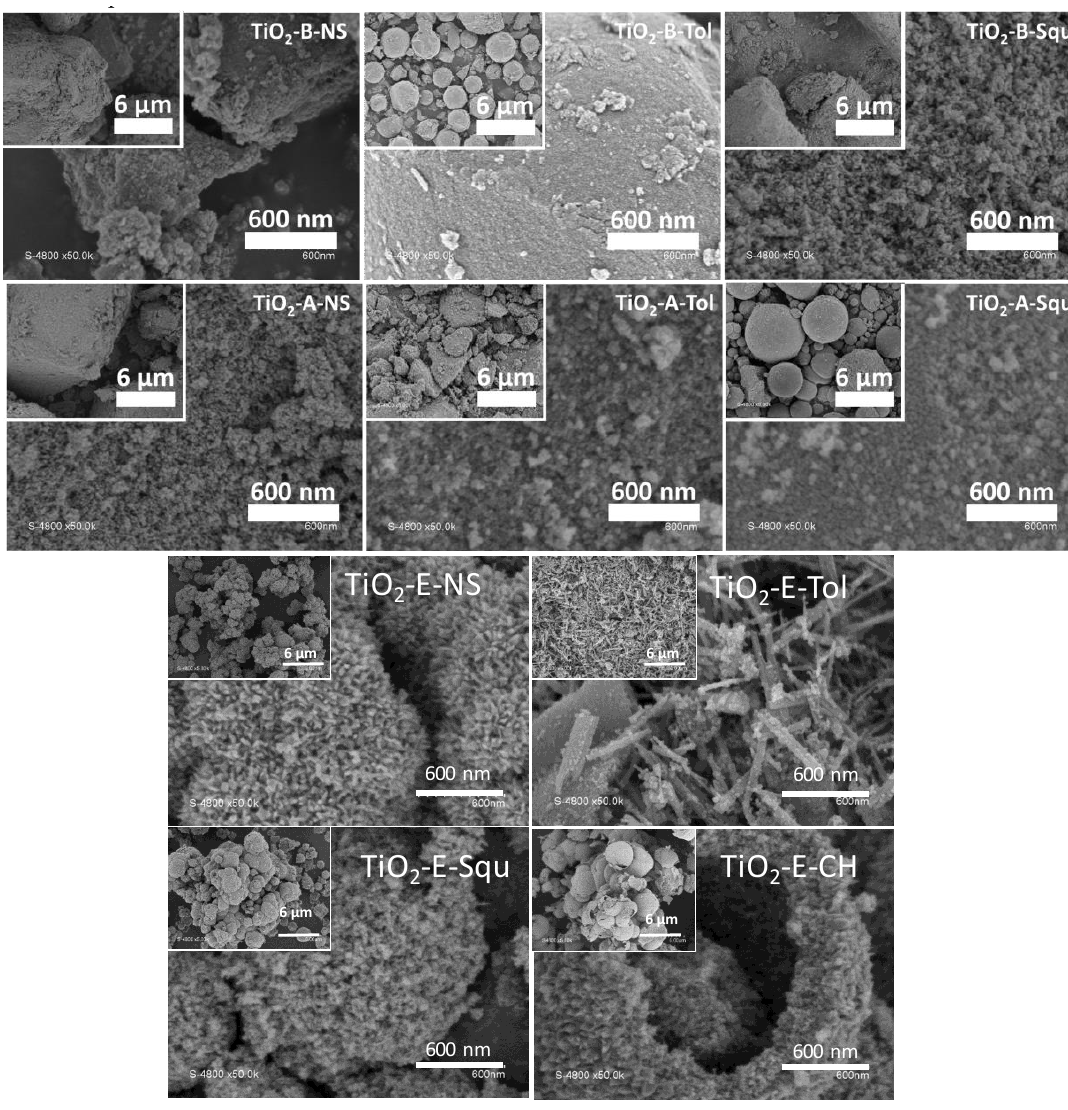
Figure 4. SEM images of calcined TiO 2 samples.